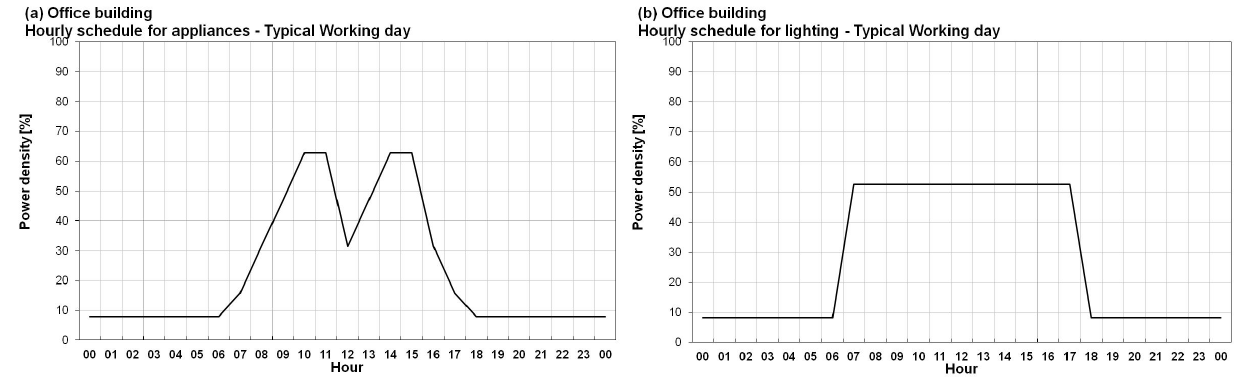
Figure 3. Hourly schedules for ( a ) appliances and ( b ) lighting use in office buildings: focus on typical working